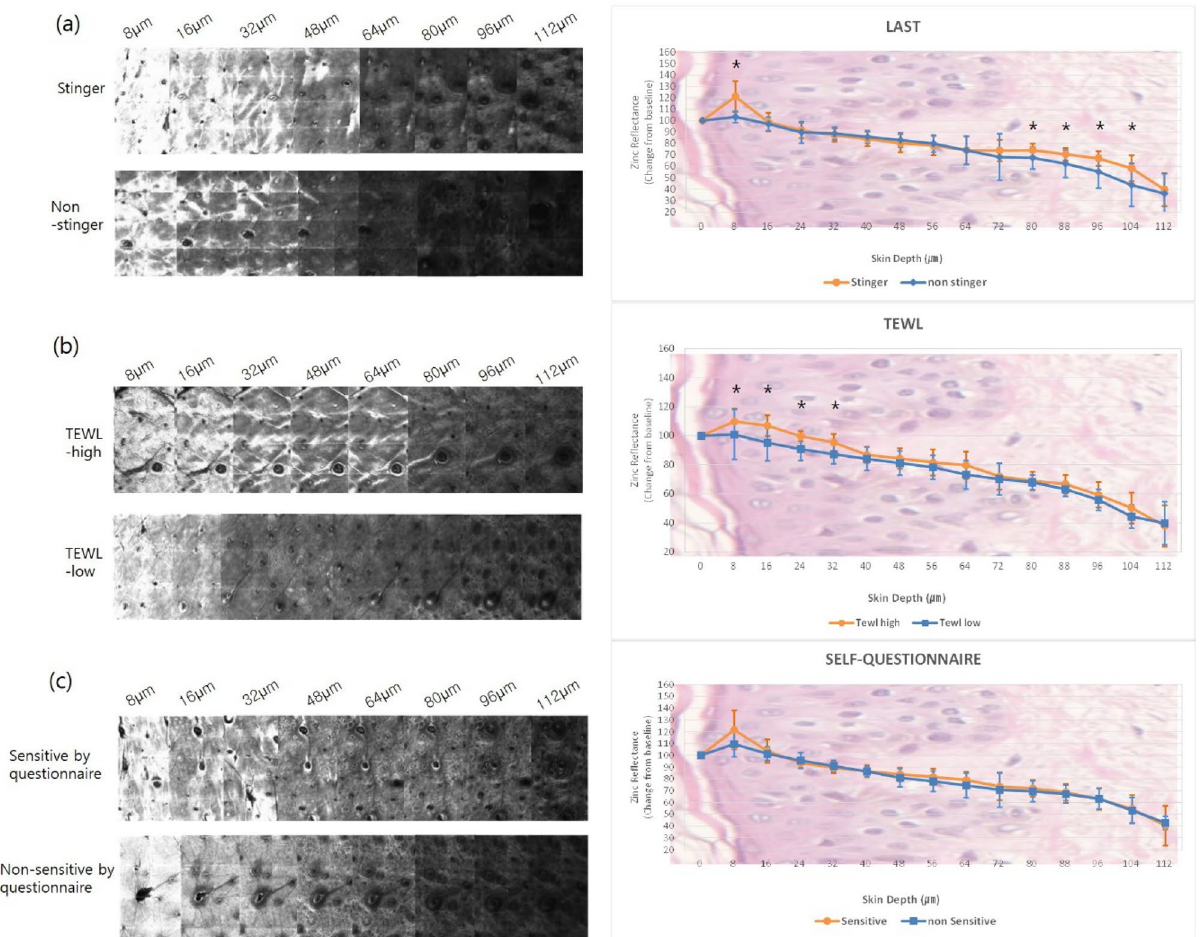
Figure 1. RCM images and the zinc reflectance values on the face. The reflectance intensity of zinc at 8 µm in the ‘stinger’ group was higher compared to the non-stinger group ( P < 0.001). There were significant differences between the two groups from 80 to 104 µm ( P = 0.048 at 80 µm, P = 0.037 at 88 µm, P = 0.008 at 96 µm, P = 0.042 at 104 µm) ( a ). The high-TEWL group showed greater zinc reflectance from depths of 8 μm to 32 μm on the face ( P = 0.011 at 8 μm, P < 0.001 at 16–32 μm) ( b ). There were no significant differences in zinc reflectance on the face in subjects self-identifying as having ‘sensitive’ or ‘non-sensitive’ skin ( c ). (* P <